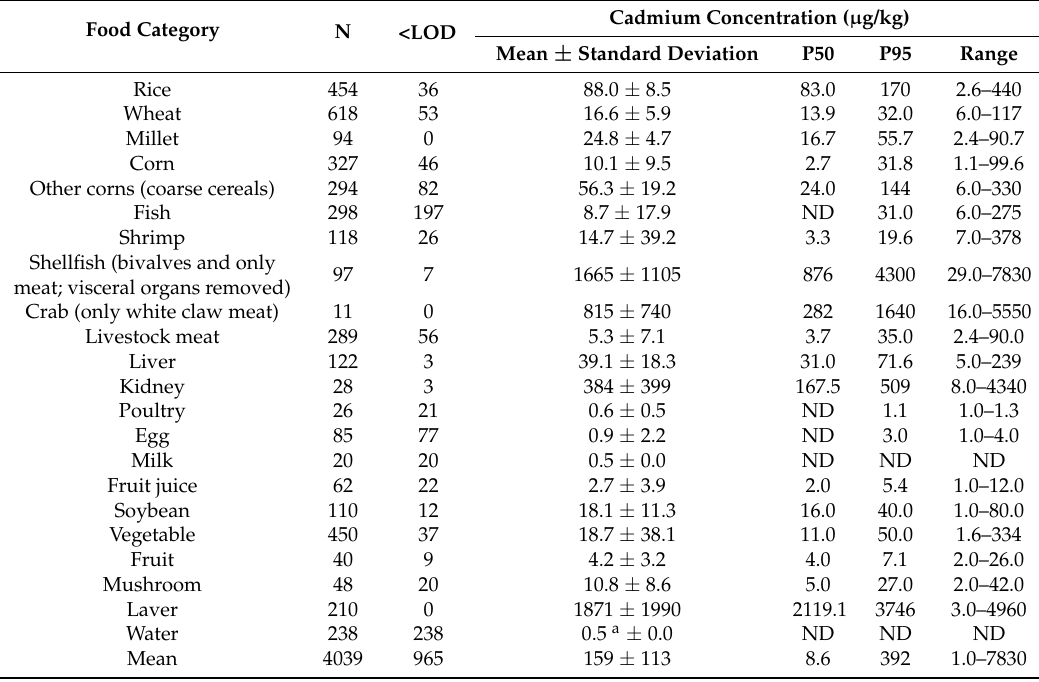
Table 1. Cadmium concentrations in food and water in Guangzhou City from 2013 to 2015. Food